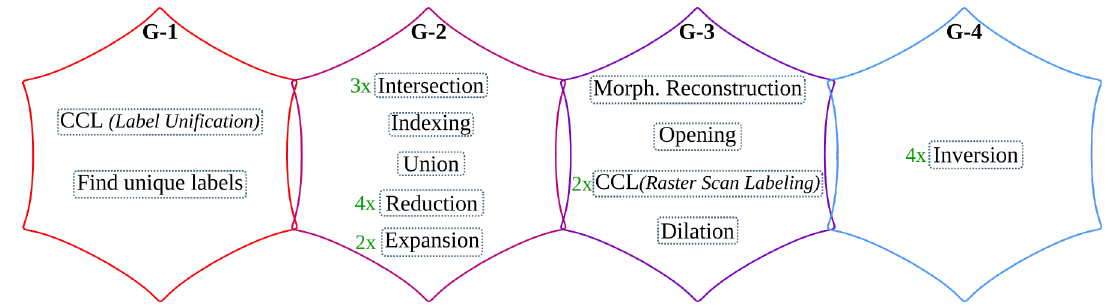
Figure 11. Operations of the text and image segmentation processing pipeline grouped from G-1 to G-4